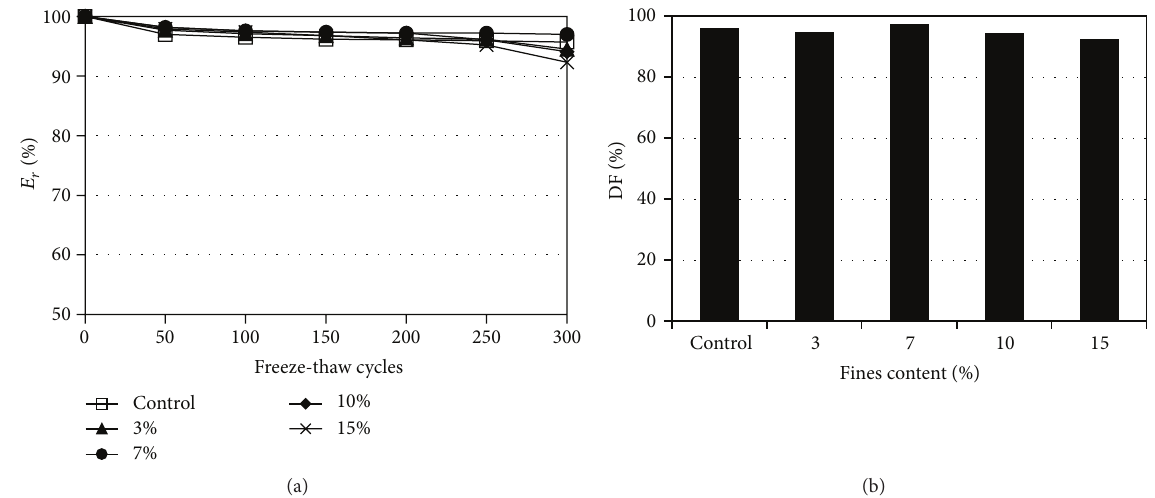
Figure 2: Effect of fines content on frost durability of C60 CSC: (a) 𝐸 𝑟 . (b) DF.